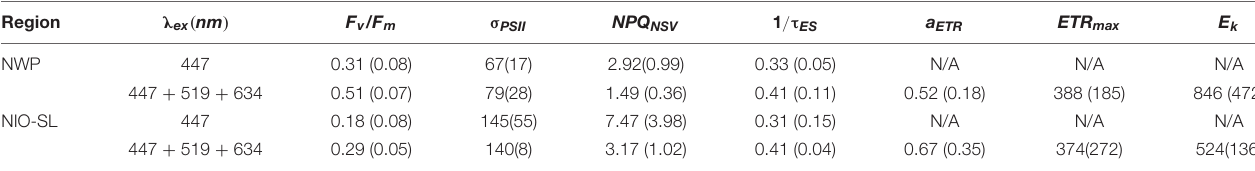
TABLE 2 | Comparison of mean (SD) of photophysiology measurement results of F v / F m , σ PSII (Å 2 PSII − 1 ), NPQ at dark ( NPQ NSV ), 1 / τ ES (ms − 1 ), a ETR (mol e − mol RCII − 1 s − 1 ( µ mol quanta m − 2 s − 1 ) − 1 ), ETR max (mol e − [mol PSII] − 1 s − 1 ), and E k (mol quanta m − 2 s − 1 ) between exciting PSII with 447 nm and with combination band (447 + 519 + 634 nm) in the NWP and